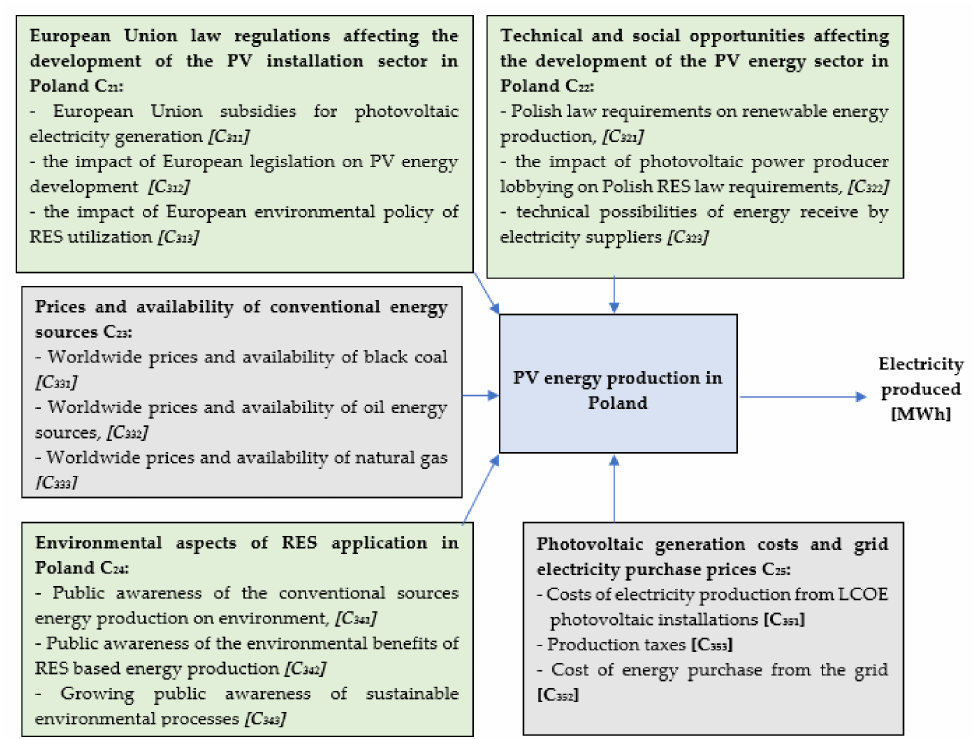
Figure 1. The set of economic and social factors influencing the selection of the most appropriate strategy for solar energy production in small PV systems in Poland. In the brackets, the levels of factors of importance used in the ETA tree are